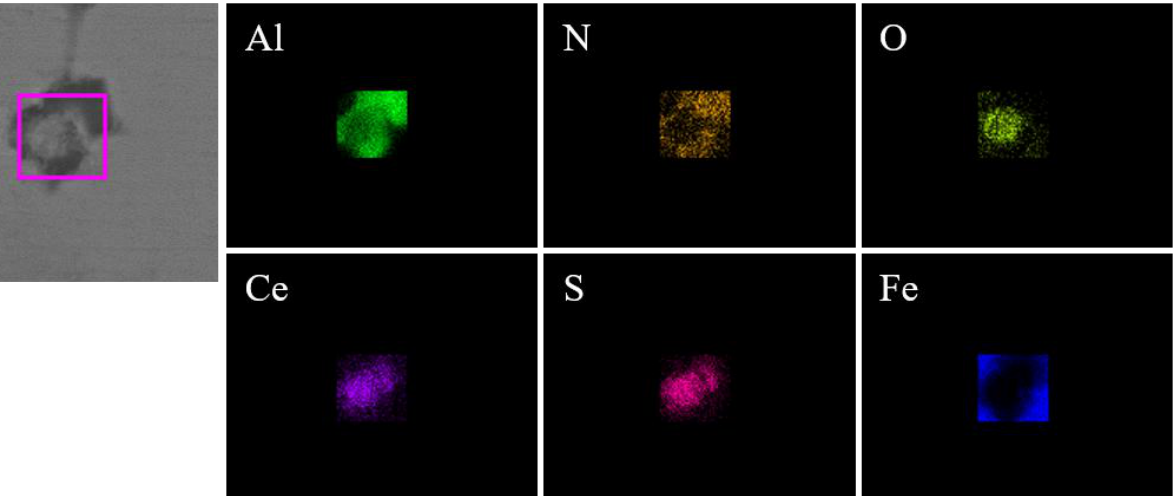
Figure 3. Elemental mapping of a typical inclusion in the steel with 10 ppm Ce content.